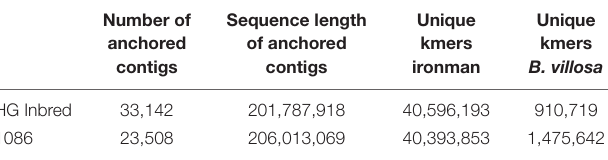
TABLE 1 | Contig anchoring and K-mer analyses of Brassica villosa introgression genotypes HG and 1086. Number of Sequence length Unique anchored of anchored contigs contigs